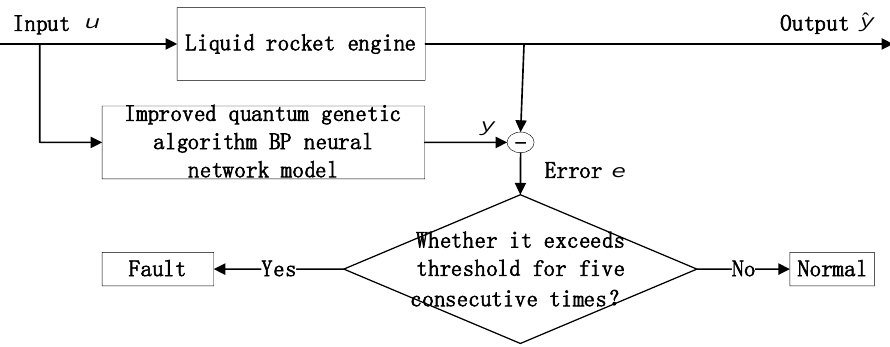
Figure 3. Fault detection method based on a quantum-genetic-algorithm-optimized BP neural network.